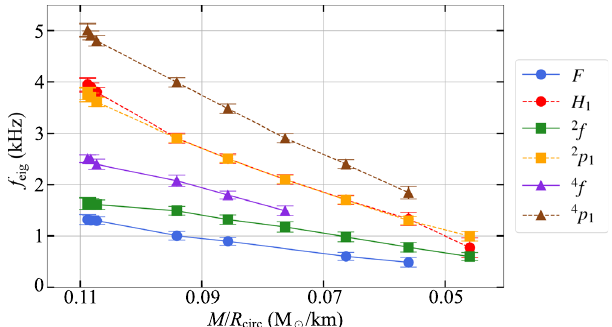
Fig. 3 Effect of magnetization on stellar compactness. Compactness M / R circ is plotted against the magnetic to binding energy ratio NS model, where M is the gravitational mass and R circ is the circumferential radius. M / R circ remains nearly unchanged for H = W ≲ 10 (cid:1) 2 but decreases dramatically for H = W > 10 (cid:1) 1 . This agrees with the trends of f eig ð H = W Þ shown in Fig. 2 and reveals a correlation between eigenfrequencies of oscillation modes and stellar compactness for magnetized NSs.